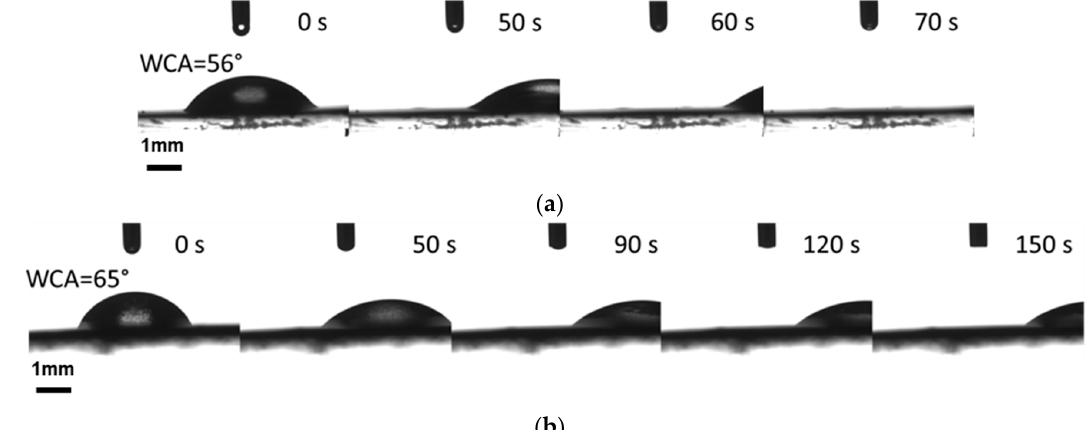
Figure 7. Sliding of water droplet at 10° tilting on PDMS/PA/BSO-PE ( a ) and PDMS/PA/BSO-PU ( b ).